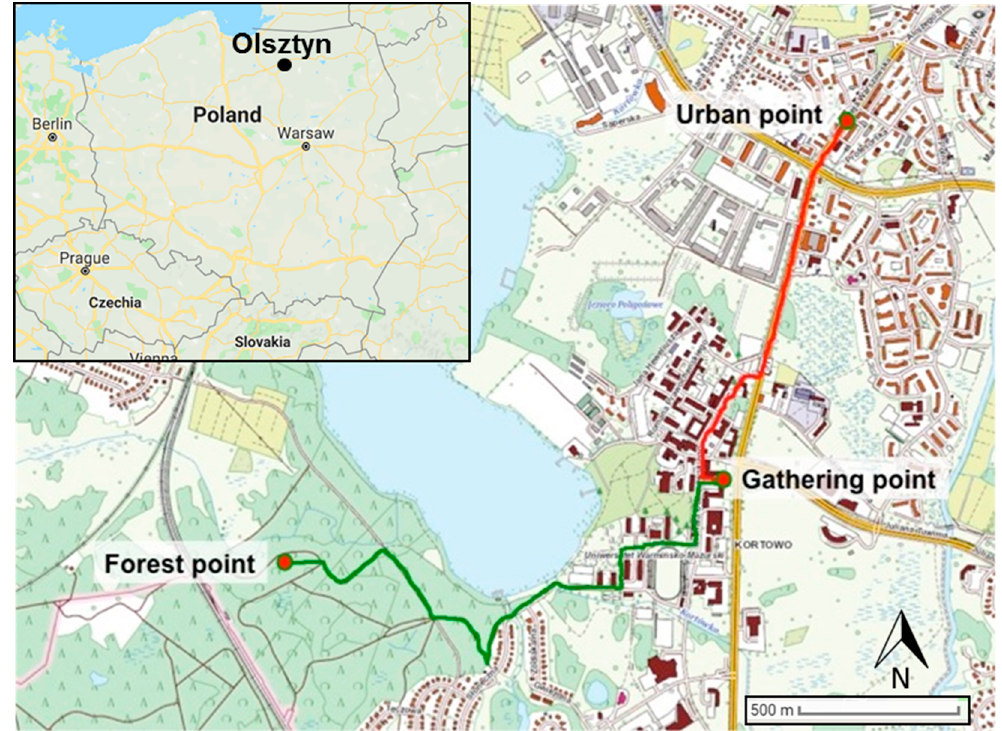
Figure 1. The map of experimental locations.